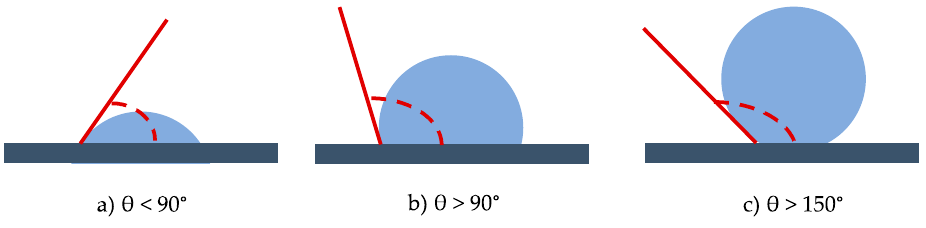
Figure 1. Water contact angles for hydrophilic ( a ), hydrophobic ( b ) and superhydrophobic ( c ) surfaces.